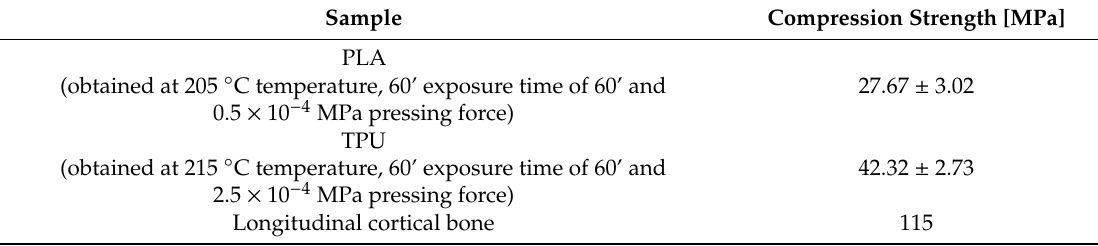
Table 2. Compressive strength comparison.